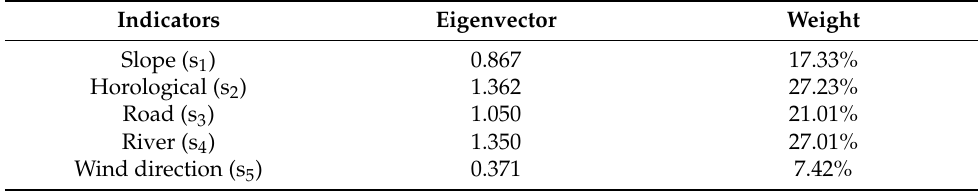
Table 4. AHP hierarchy analysis results.